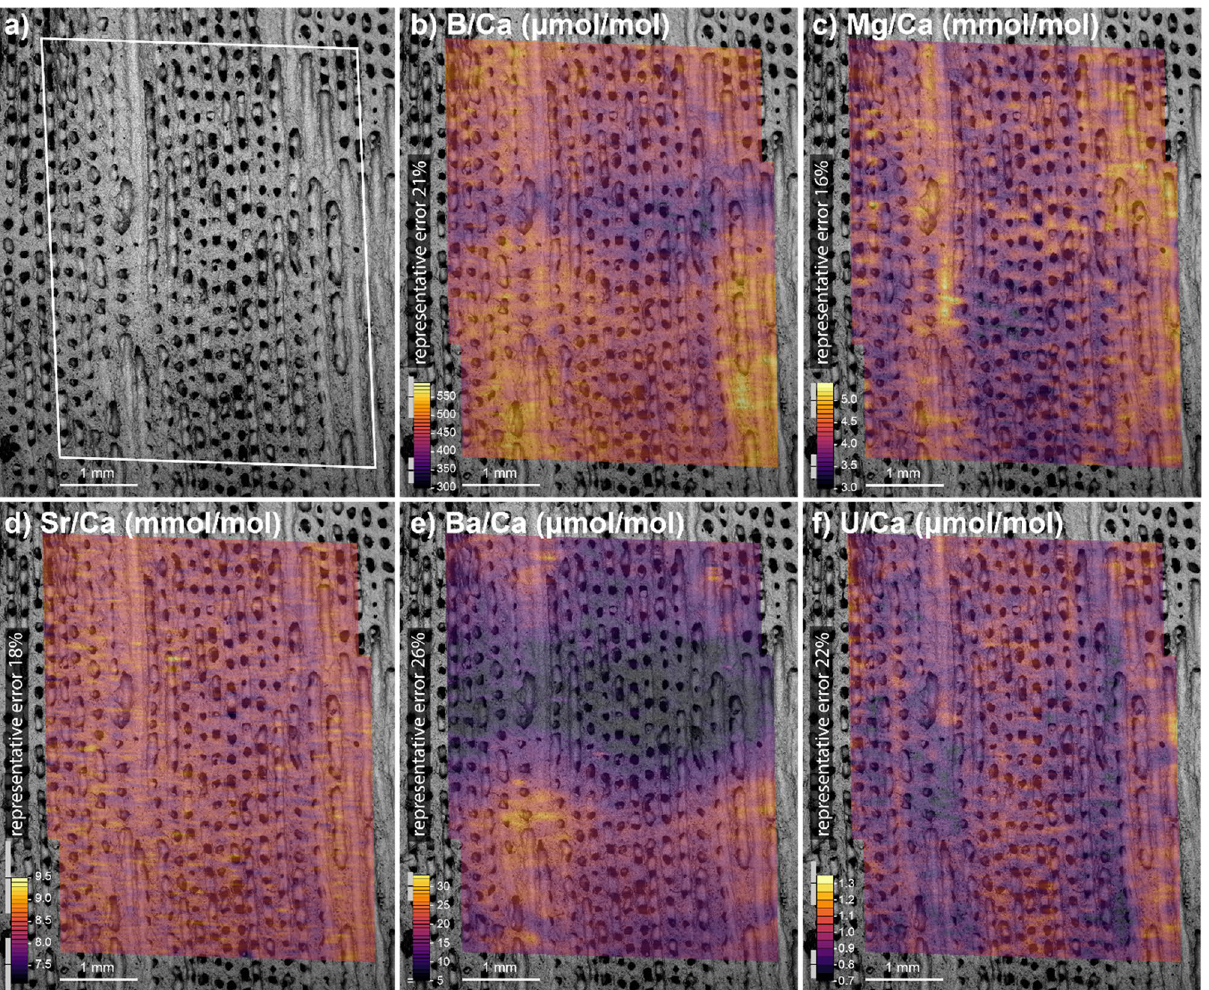
Figure 4. ( a ) Pre-ablation SEM image of the coral area analysed by LA, note the element ratio plots were analysed prior to the δ 11 B analyses as they utilise less material. The following plots are mapped onto the SEM image with high values shown in yellow colours and low values in purple: ( b ) B/Ca in µmol/mol ranging from < 350 to > 550 µmol/mol, B/Ca has a strong seasonal variation associated with changes to the internal carbonate system of the coral; ( c ) Mg/Ca in mmol/mol ranging from < 3.5 to > 5.0 mmol/mol; ( d ) Sr/Ca in mmol/mol ranging from < 8.0 to > 9.0 mmol/mol; ( e ) Ba/Ca in µmol/mol ranging from < 10 to > 30 µmol/ mol, the Ba/Ca shows a strong seasonal cycle associated with riverine input, we note the visible undulation to the growth horizon as also seen in the B/Ca data showing the gross morphology of a coral polyp with raised theca walls and a depressed central polyp at any given time-step; ( f ) U/Ca in μmol/mol ranging from < 0.8 to > 1.1 µmol/mol. All trace and major element cations are higher concentration in the theca walls, with the exception of uranium (panel f ). Uncertainties in the element ratios are shown as representative error bars at the top and bottom of the colour bars, for further information see Laser Ablation ICP-MS section in the